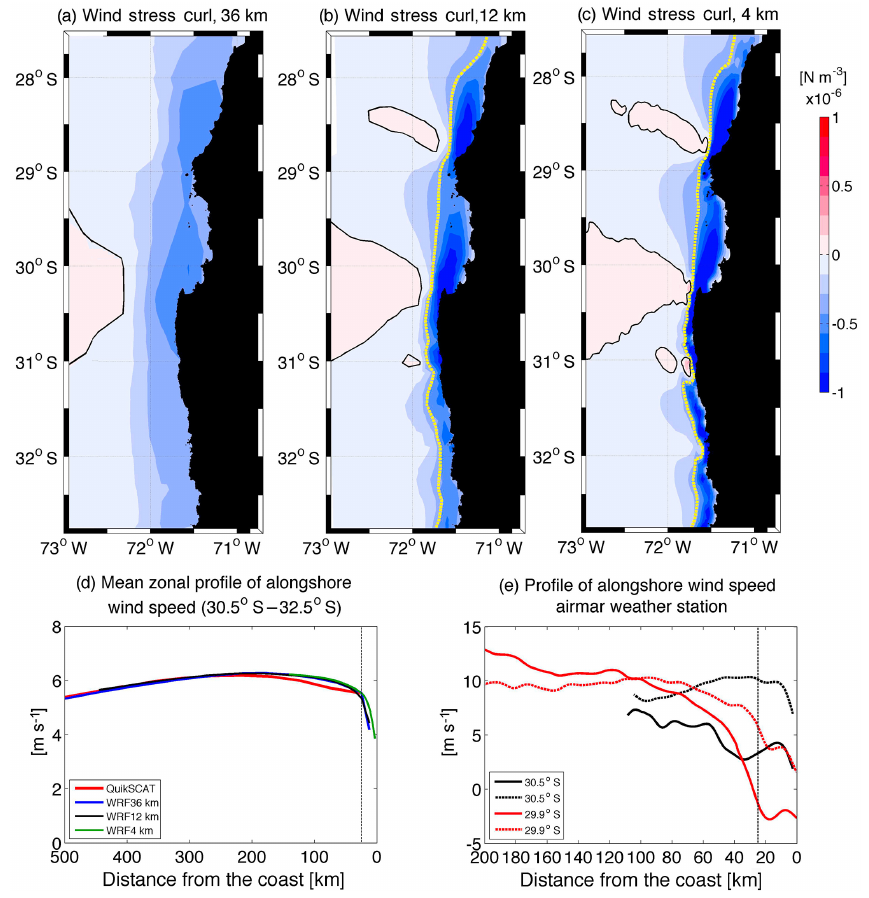
Figure 3. Mean wind stress curl obtained by the model (for 2007–2012) using three model domains: (a) 36, (b) 12 and (c) 4km. The yellow dotted line represents the length scale of the wind drop-off determined from a threshold value of − 0.3 × 10 − 4 s − 1 (Renault et al., 2015). (d) Mean zonal profiles of alongshore wind speed obtained from the three model configurations (36, 12 and 4km) and QuikSCAT observations are shown. (e) Zonal profiles of alongshore wind speed from a weather station obtained onboard of a fishing boat during 22 April (black line), 18 May (black dashed line), 15 September (red line) and 28 October (red dashed line) of 2014 are also shown. The segmented line in (d) and (e) indicates the location of the satellite blind